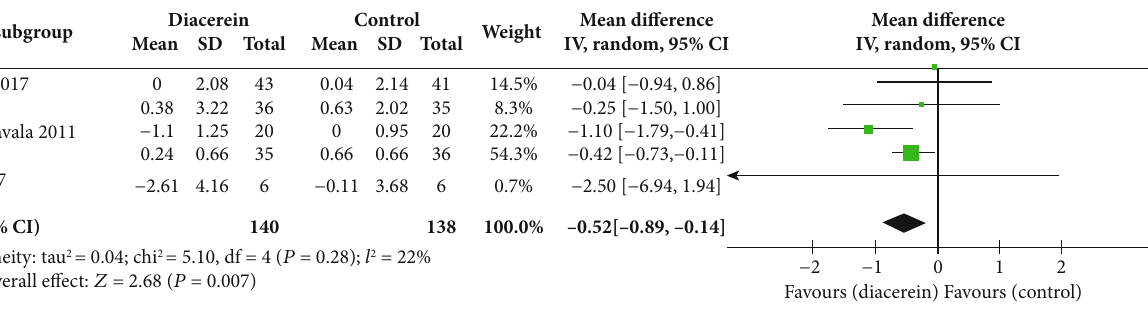
Figure 3: Di ff erence in fasting blood glucose between diacerein and control.